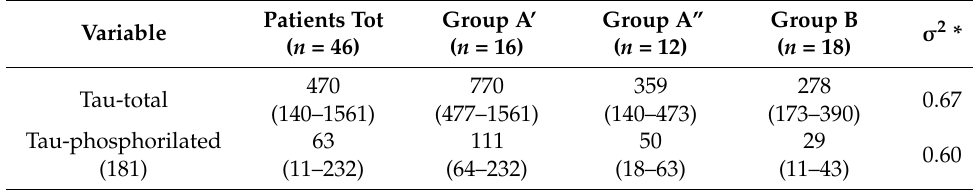
Figure 4. Subdivision of patients into Groups A’, A”, and B according to the expression of Tau- total ( A ) and Tau-phosphorylated ( B ). The dotted line represents the threshold for a subject to be considered AD or normal; the arrow indicates the direction of values for which the subjects are not affected by AD. Group A’ is depicted in light gray, Group A” is depicted in medium gray, and Group B is depicted in dark gray. Table 4. Average values recorded for each variable, Tau-total and Tau-phosphorilated. The minimum and maximum values are shown in parentheses; σ 2 is the variance of the values according to “one-way